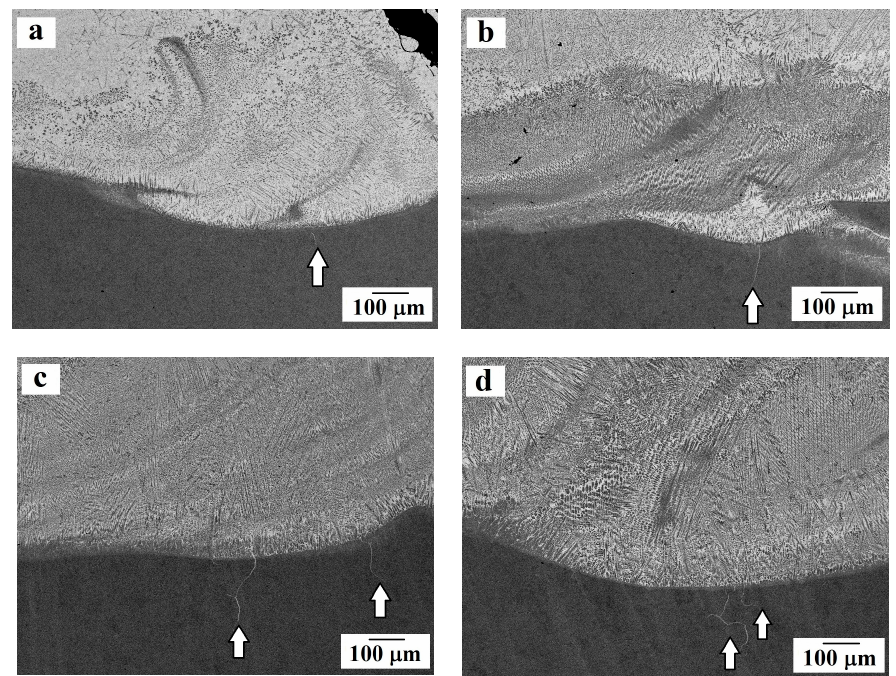
Figure 3. The microstructure of the substrate-coating contact zone (according to SEM data). General views for samples: ( a ) No. 2; ( b ) No. 3; ( c ) No. 4; ( d ) No. 5. Arrows indicate microcracks filled with